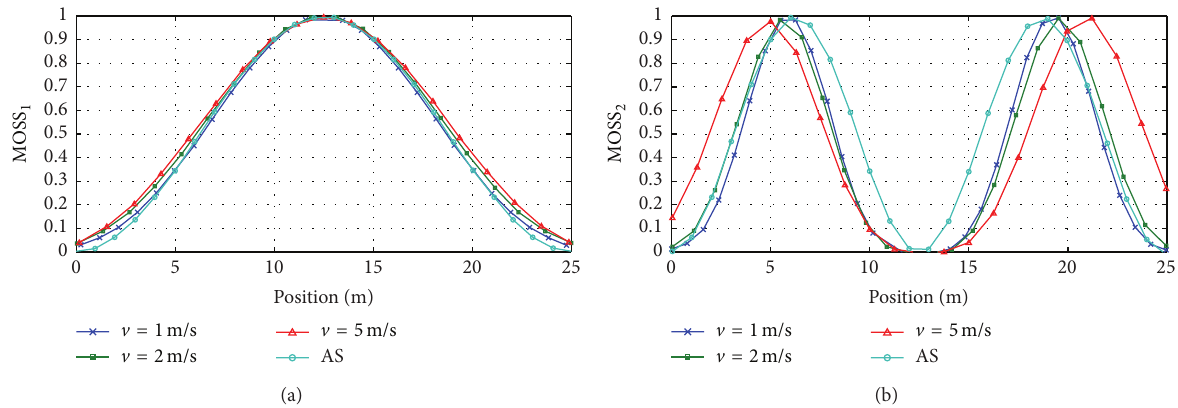
Figure 6: The extracted MOSS at different vehicle speeds compared with analytical solution: (a) mode 1 and (b) mode 2 ( V is the velocity of the passing vehicle and AS is the analytical solution), after [14].